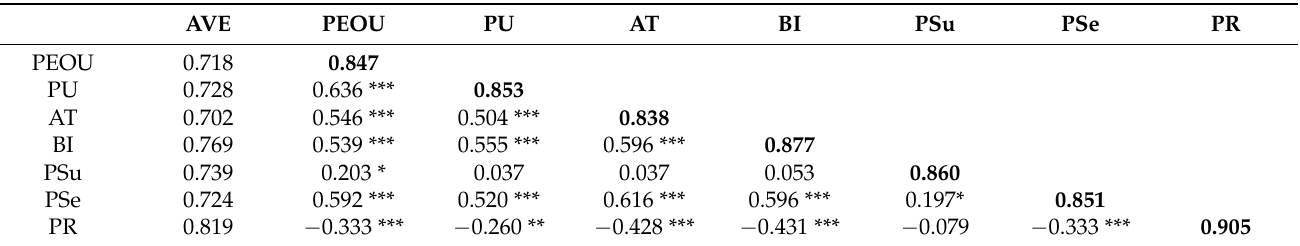
Table 7. Discriminant validity of the measurement